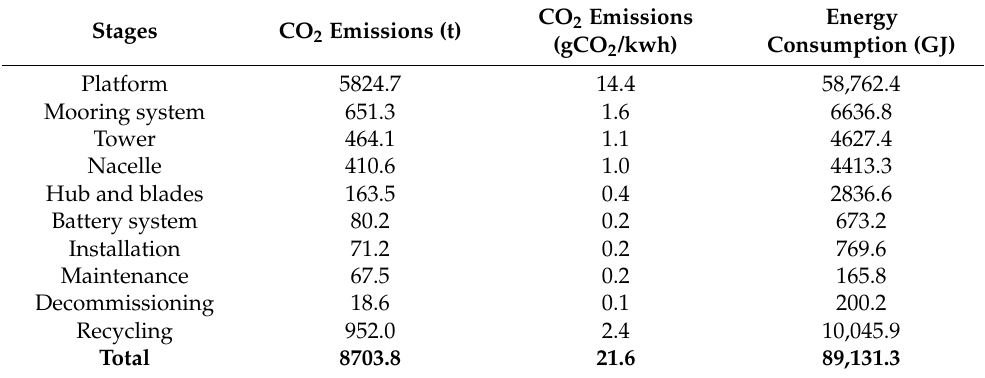
Table 7. CO 2 emissions and energy consumption for each stage of the project